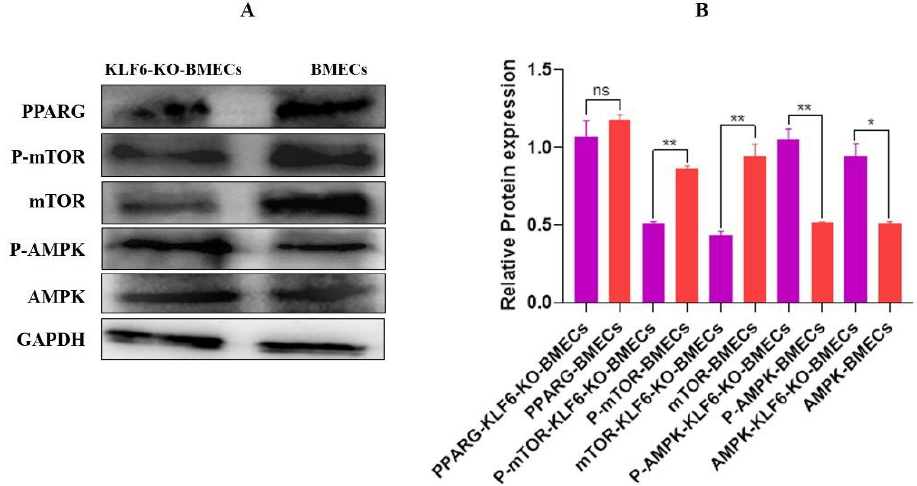
Figure 13. Protein expression of lipid metabolism-related genes ( A , B ) The relative protein expression of AMPK/mTOR/PPARG in the KLF6 -KO-BMECs and normal BMECs. * p < 0.05, ** p <